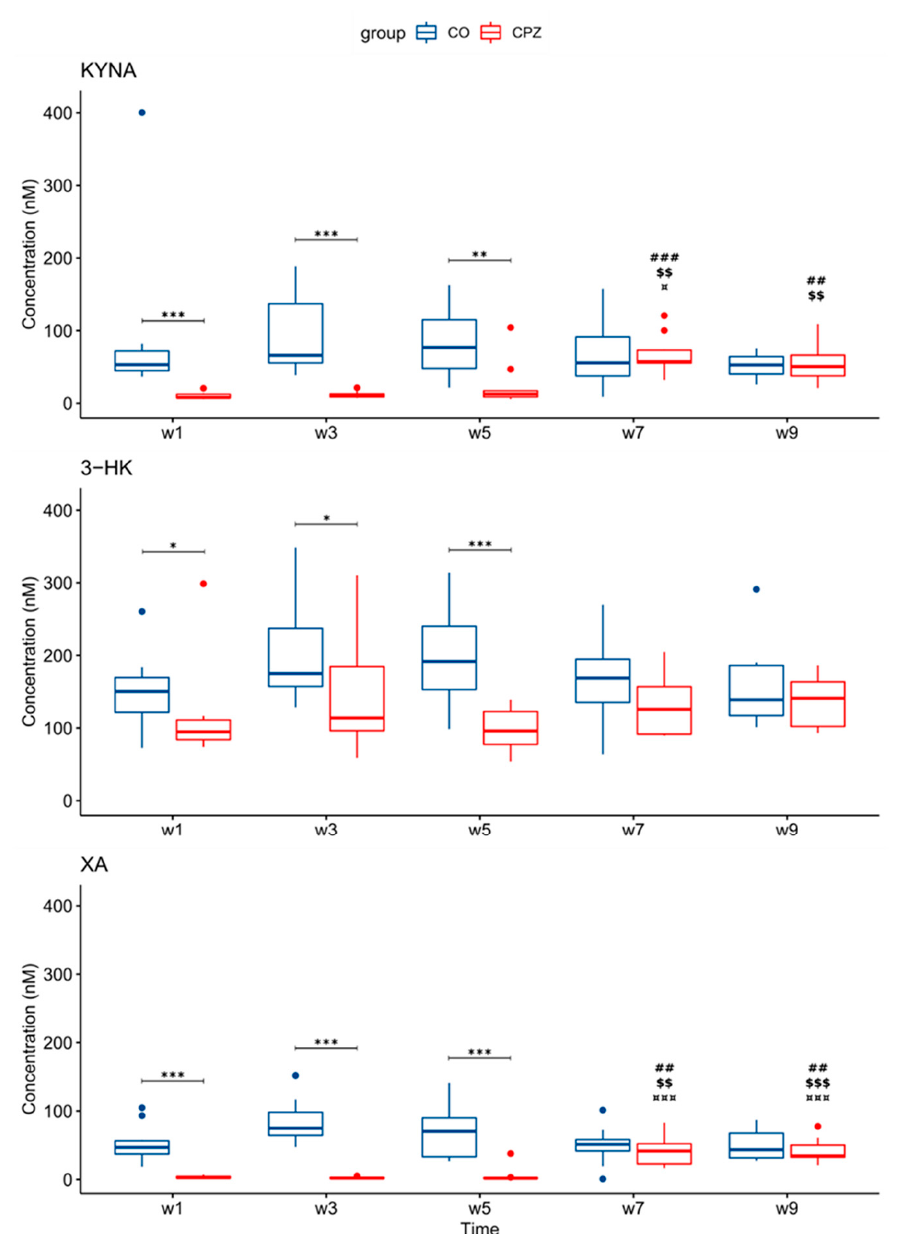
Figure 3. Changes in kynurenine metabolites during weeks of cuprizone treatment in the plasma of cuprizone-treated and control groups. In the first week of the CPZ treatment, a significant decrease in KYNA, 3-HK, and XA levels was observed in the CPZ group compared to the control, and differences remained until the end of the CPZ intoxication. In the first half of the recovery phase, these differences disappeared during remyelination between groups. 3-HK: 3-hydroxy-L-kynurenine; CO: control group; CPZ: cuprizone group; KYNA: kynurenic acid; XA: xanthurenic acid; w: week; *: p < 0.05: **: p < 0.01; ***: p < 0.001: ##: p < 0.01; ###: p < 0.001 compared to week 1; $$: p < 0.01; $$$: p < 0.001 compared to week 3; ¤: p < 0.05; ¤¤¤: p < 0.001 compared to week 5.